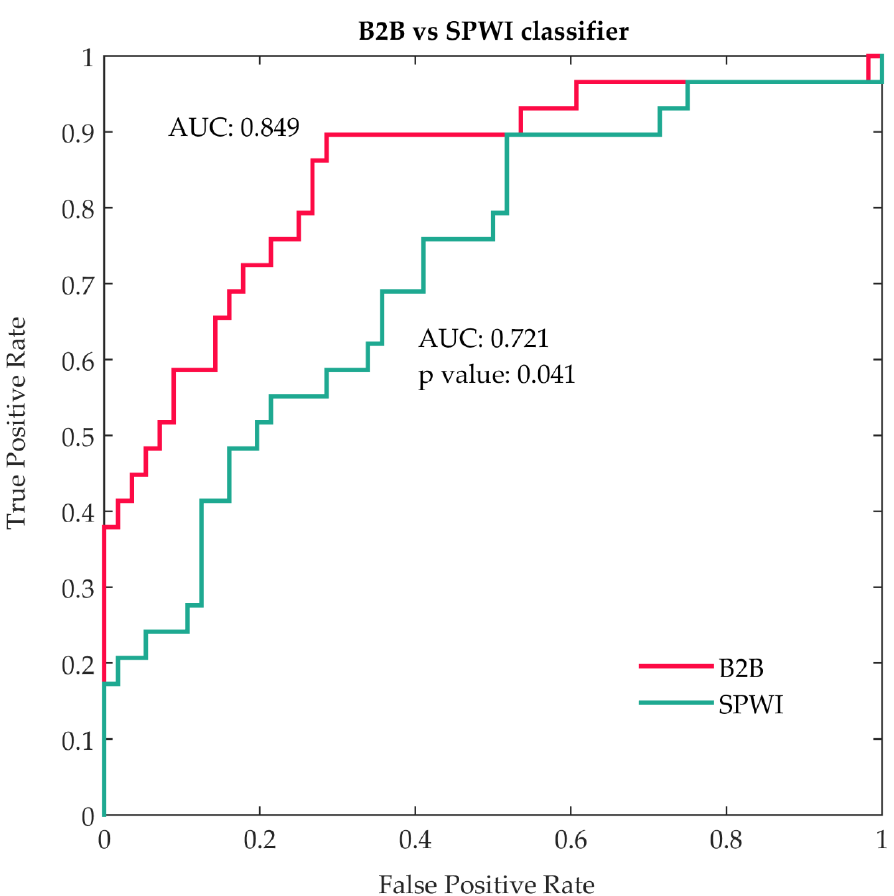
Figure 1. Comparison between beat-to-beat and standard P-wave indices classifiers. Abbreviations: B2B: beat to beat; SPWI: standard P-wave indices; AUC: area under the curve.